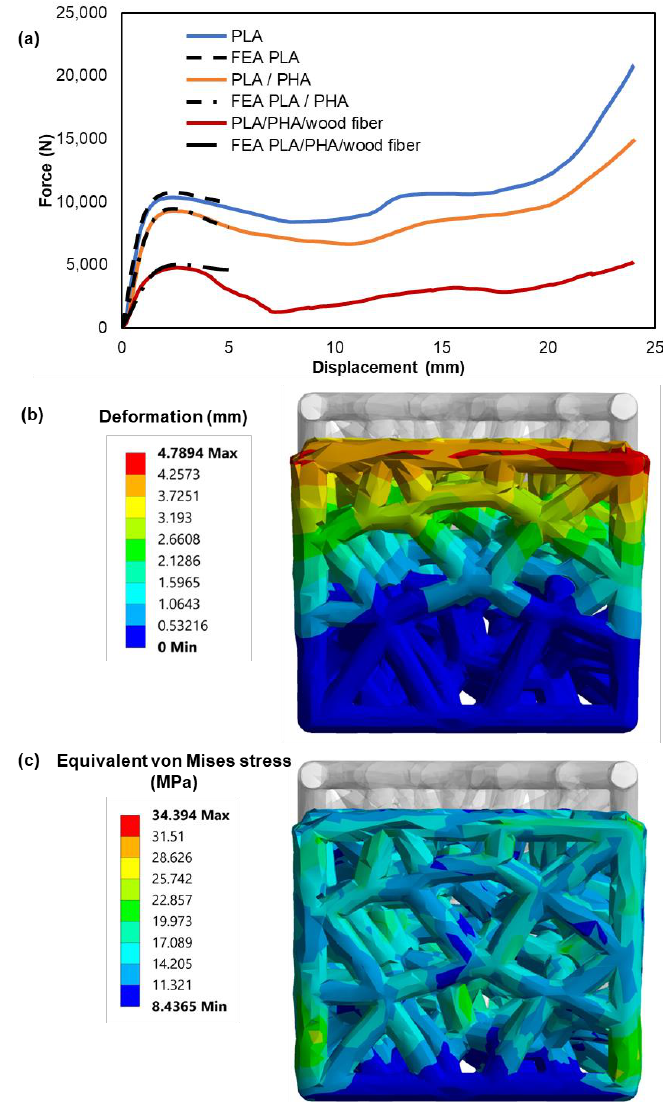
Figure 14. ( a ) Experimental load–displacement response for the Voronoi lattice structures curve-fitted by FEA generated data, ( b ) vertical deformation and ( c ) stress distribution of the Voronoi structure under compression load, utilizing the PLA material properties in the FE model.